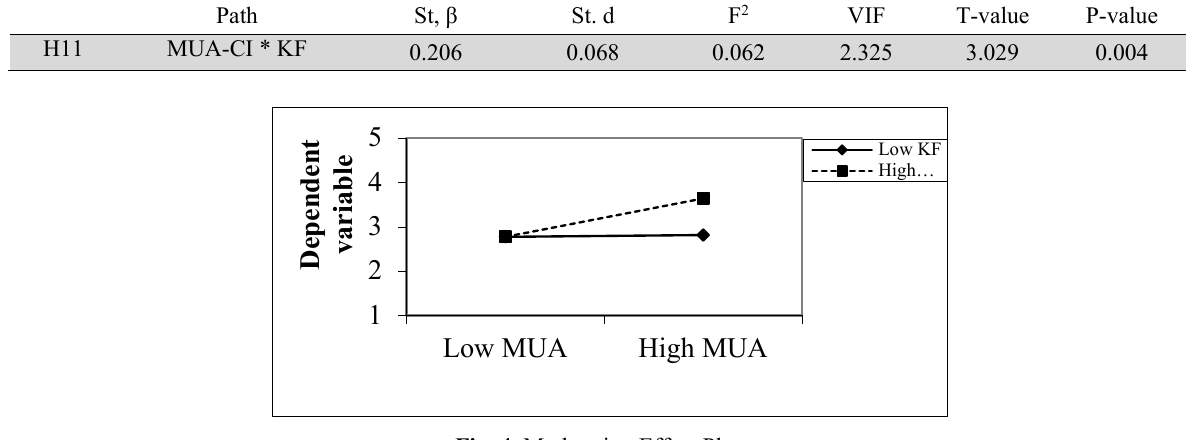
Fig. 4. Moderating Effect